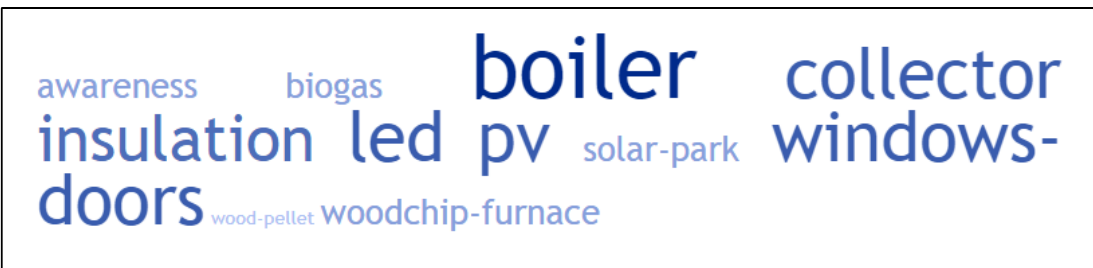
Figure 9. A word frequency graph on locally implemented energy efficiency (EE) and renewable energy resources (RES) projects (authors’ edition).